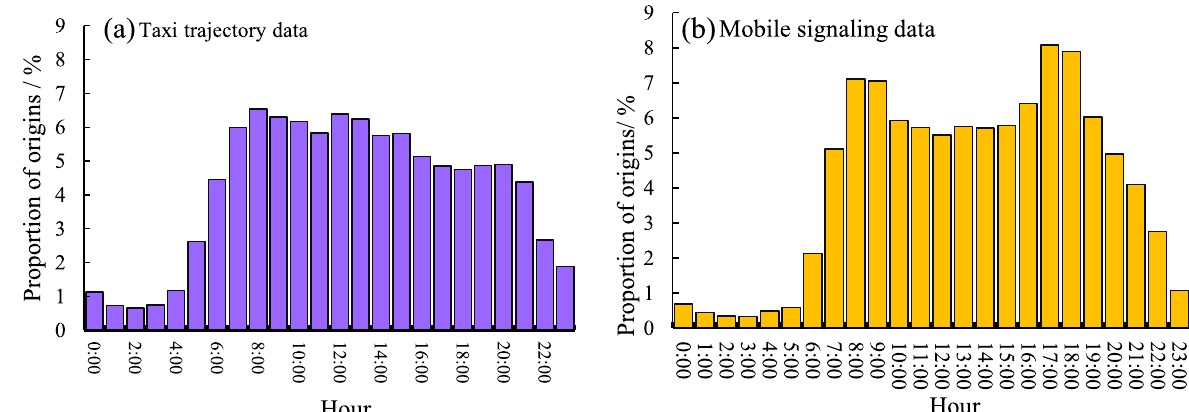
Fig. 2 Distribution of travelers by hour between January 9th and January 13th, 2017 from taxi trajectory data ( a ) and mobile signaling data ( b